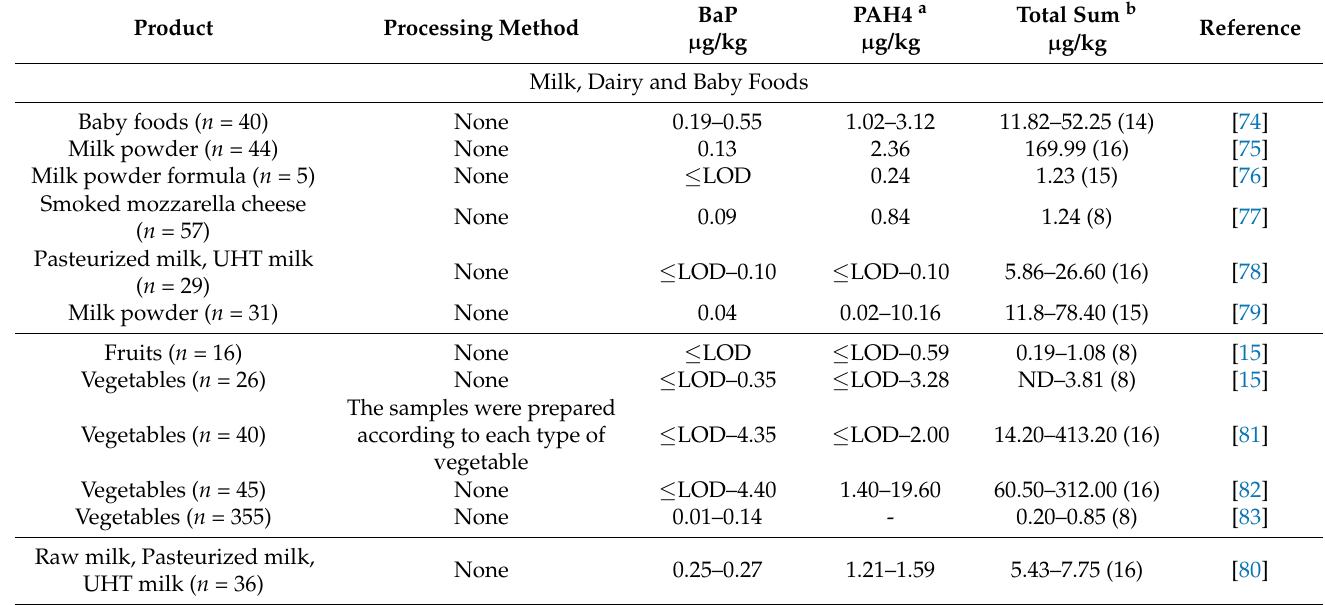
Table 4. Summary of PAHs concentrations in various food